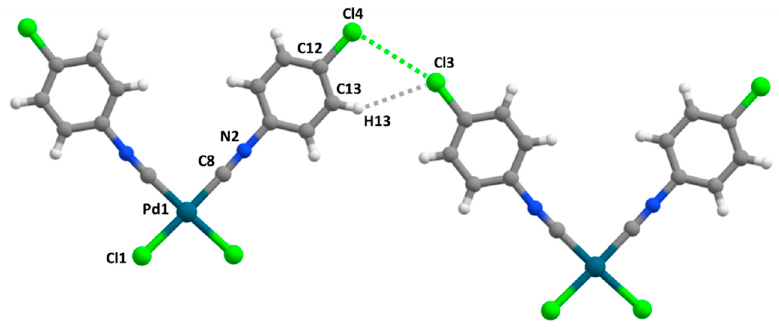
Figure 3. View of dimeric cluster of type I for 1 .